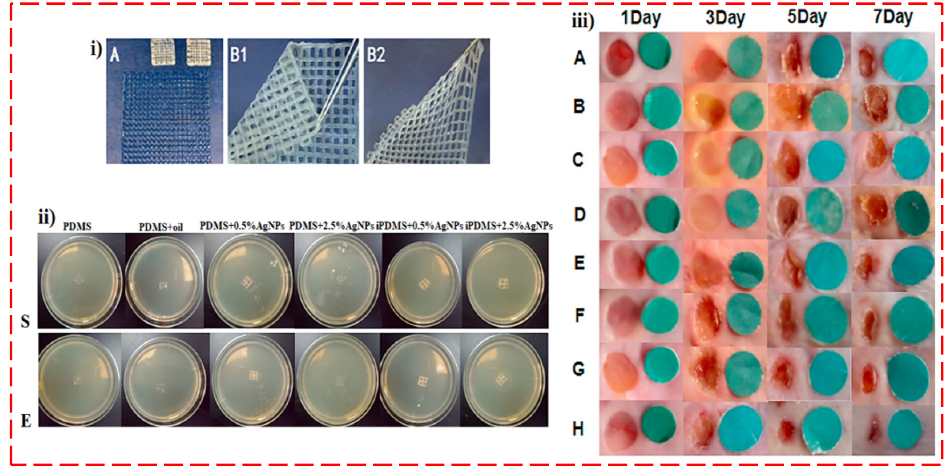
Figure 10. ( i ) Micrographs of 3D-printed mesh and nanosilver dotting. A: iPDMS membrane with flexibility and different sizes; B1: folded oil-infused 3D-printed polydimethylsiloxane with antibacterial nanosilver (iPDMS/AgNPs), and B2: stretched PDMS/AgNPs. ( ii ) The gross appearance of bacteria in the six groups (co-cultured with S. aureus or E. coli ). ( iii ) The wound profiles of the infected wound from 1 day to 7 days [135]. Note: Negative control ( A ), positive Control ( B ), PDMS ( C ), PDMS + oil ( D ), PDMS + 0.5%AgNPs ( E ), PDMS + 2.5%AgNPs ( F ), PDMS + 0.5%AgNPs + oil ( G ), and PDMS+2.5%AgNPs+oil ( H ).